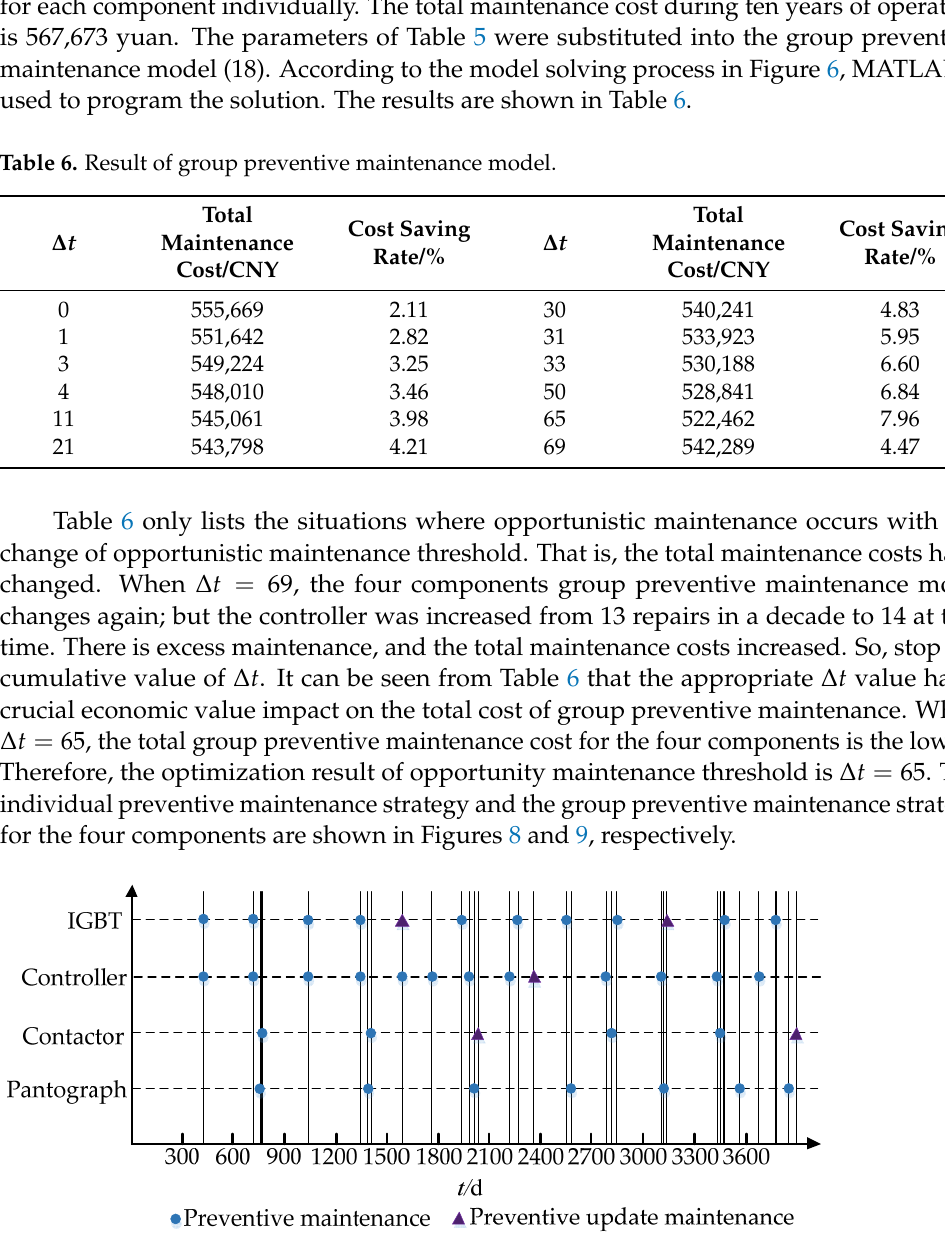
Figure 8. Separate preventive maintenance strategy of each component.